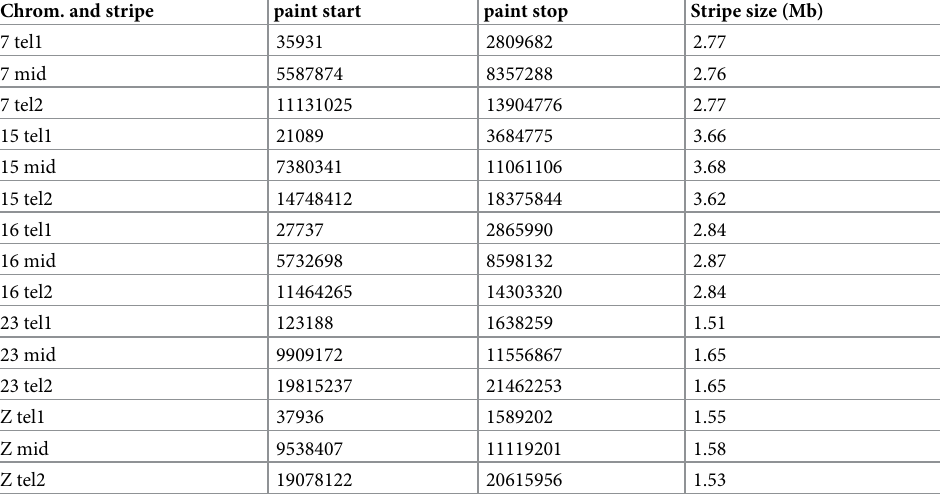
Table 2. Stripe sub-library paint information. Chrom. and stripe paint start paint